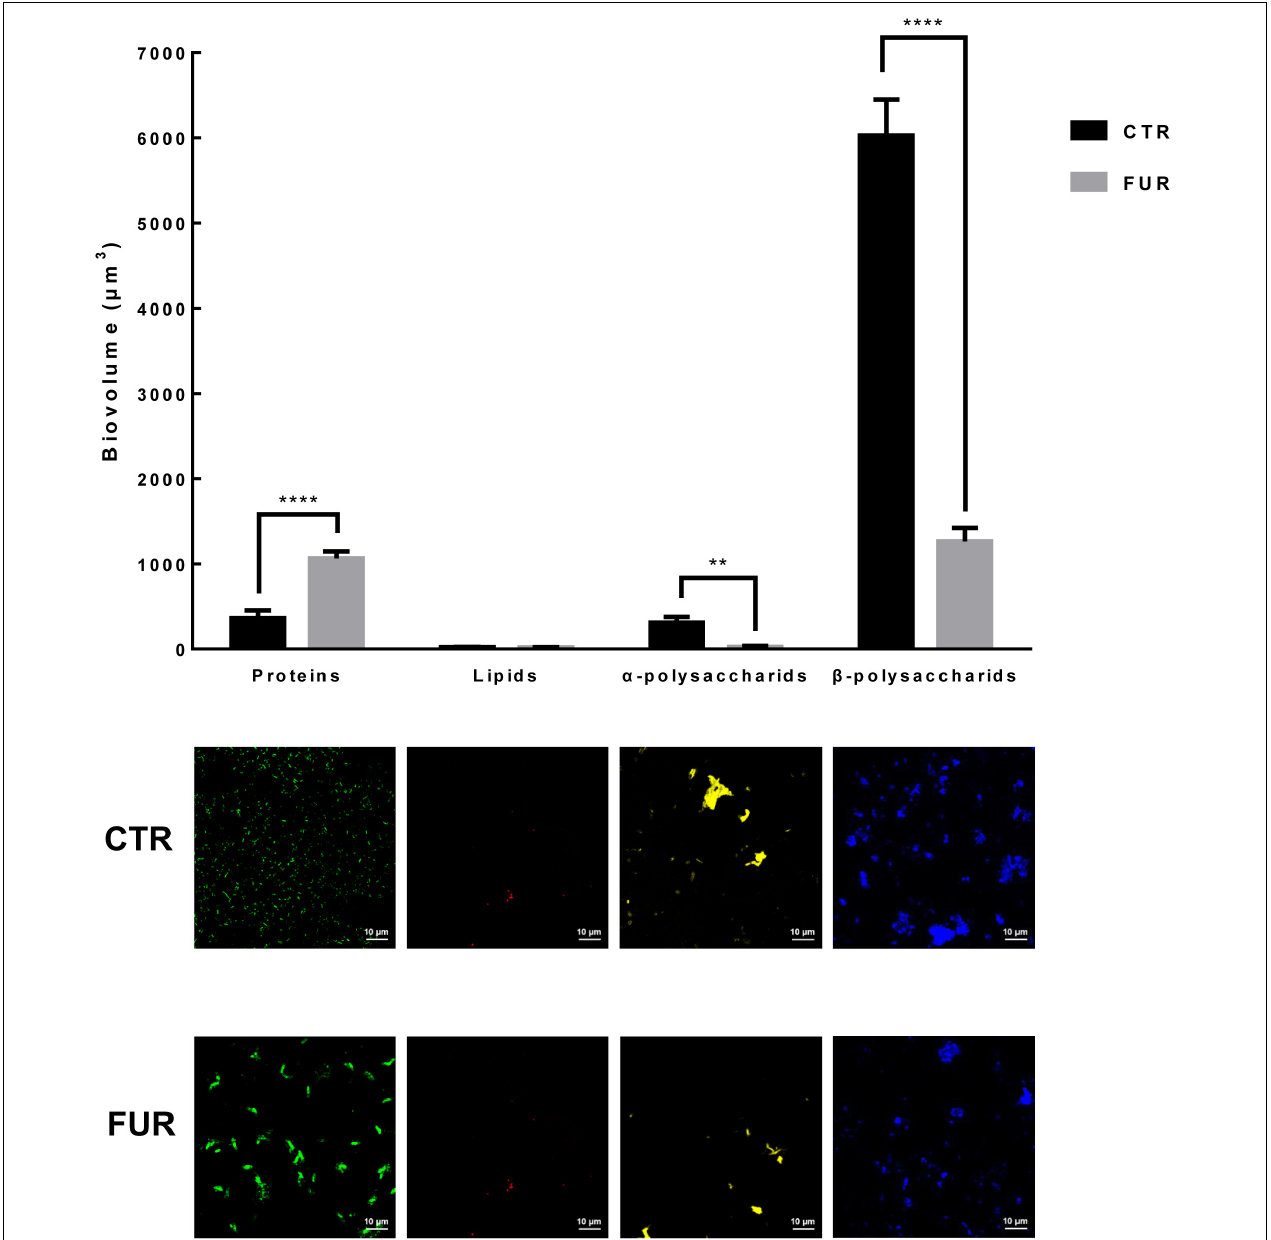
FIGURE 3 | Biovolume of the individual components in biofilms formed by P. marina ECSMB14103. Images of each component are shown. ** p < 0.01; **** p < 0.0001. Control (CTR), P. marina ECSMB14103 biofilm prepared on a sterile glass slide without adding FUR; FUR, 10 4 M FUR treated P. marina ECSMB14103